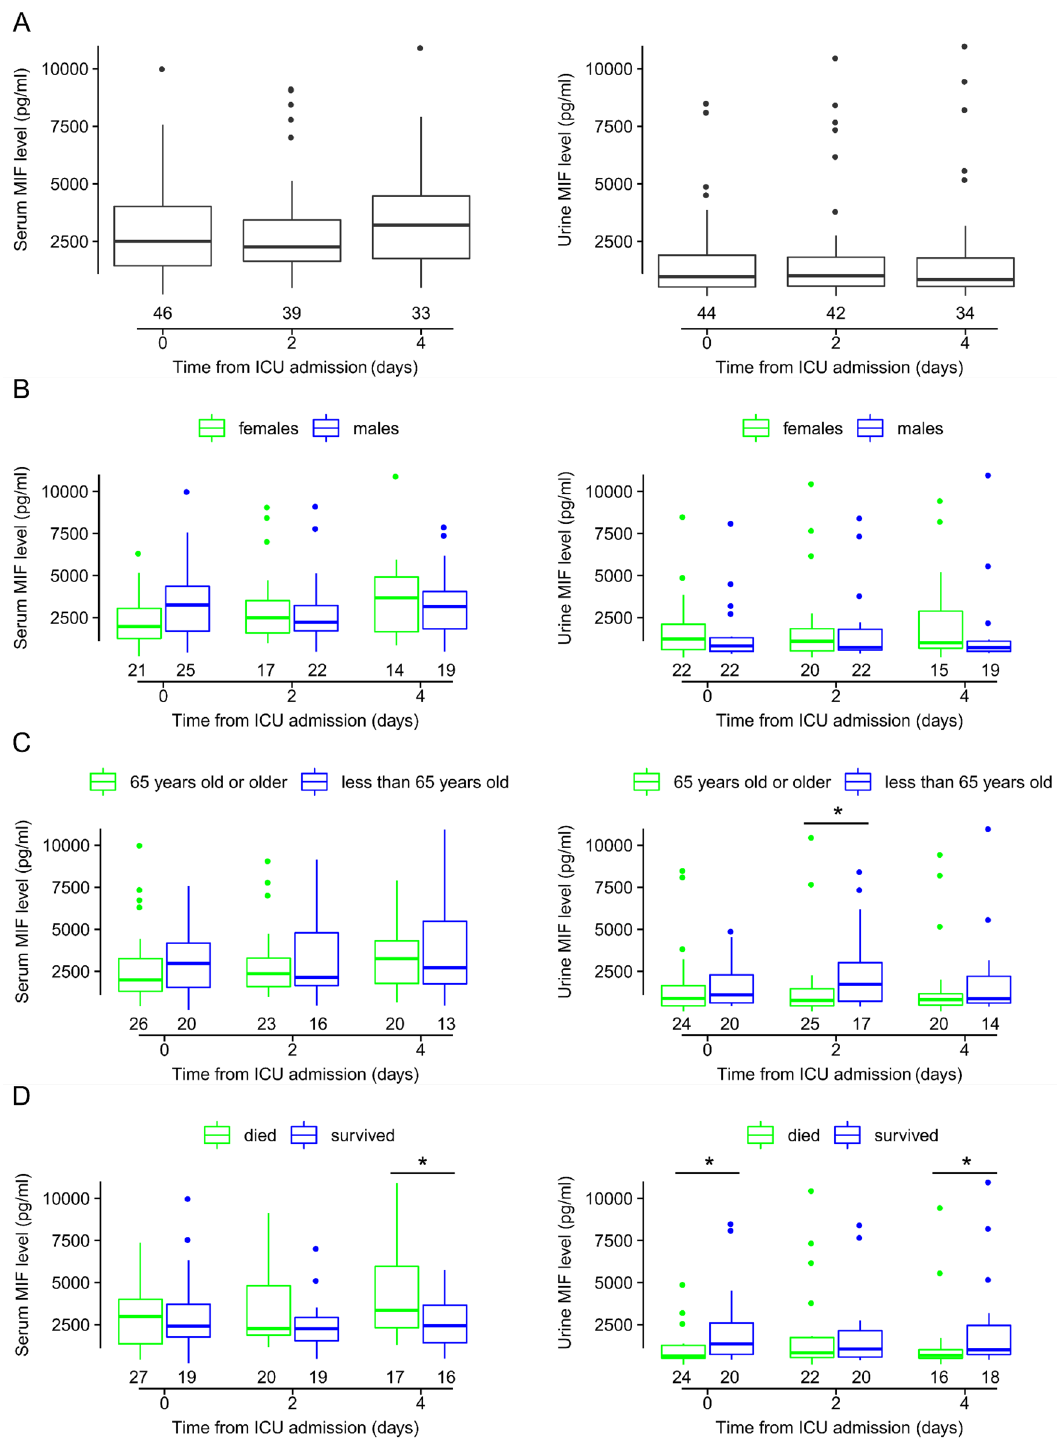
Figure 2. The serum and urine levels of macrophage migration inhibitory factor (MIF) in septic patients on days 0, 2, and 4 from admission to the intensive care unit (ICU). The MIF levels are shown in ( A ) all patients and in patient subgroups of ( B ) females and males, ( C ) at least 65 years old and younger than 65 years, and ( D ) deceased and survived. Here, and in Fig. 6A, the horizontal line within each box represents the median, the bottom and the top of the box marks the lower and the upper quartile, respectively, which limit the interquartile range (IQR). The vertical line below and above the box shows the minimum and maximum levels, respectively. Outliers are shown with dots. The numbers below the boxes indicate the number of patients in each group. Note that on day 0, serum MIF level could not be determined in 4 patients and urine MIF level in 6 patients due to technical issues. * p <